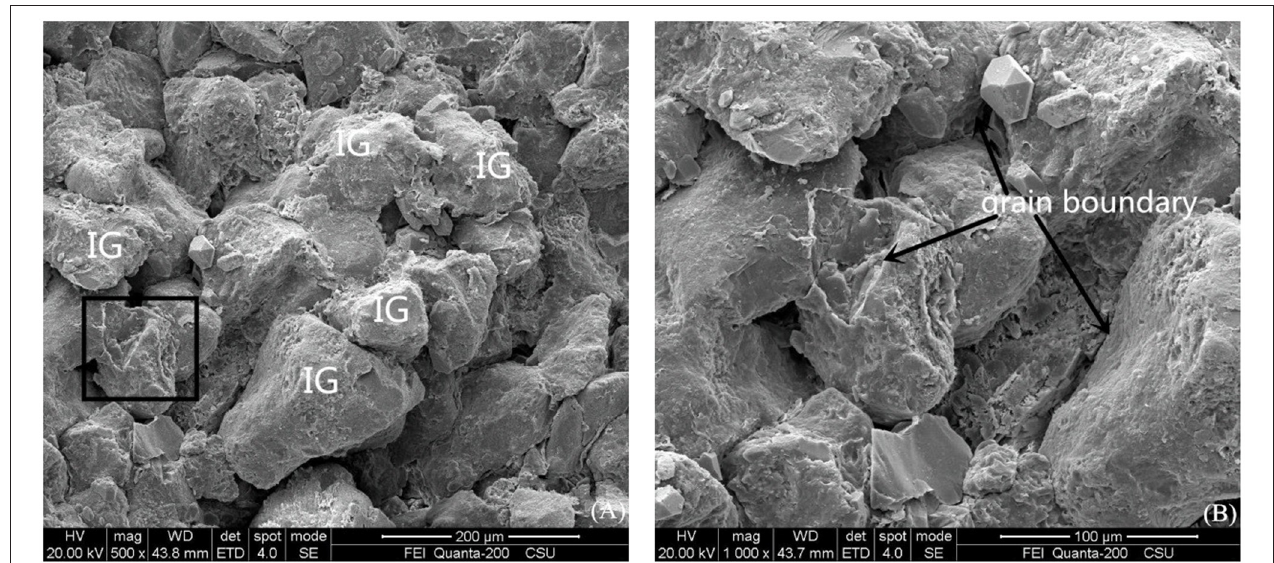
FIGURE 7 | SEM photos of the fracture surfaces for sandstone under the Brazilian split test. (B) is an inter-granular fracture surface which is amplified in black square for (A) and shows “candy” shape.